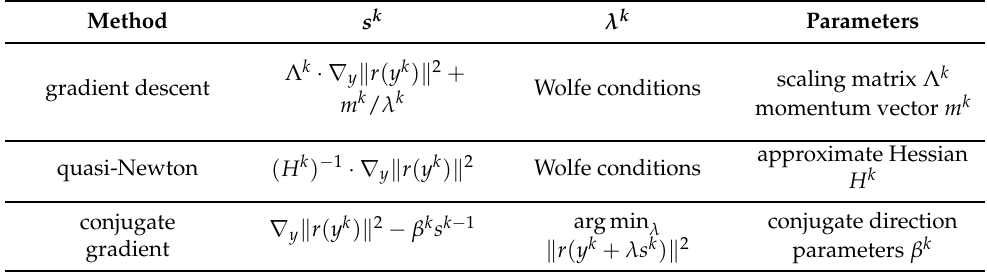
Table 2. Common descent algorithms